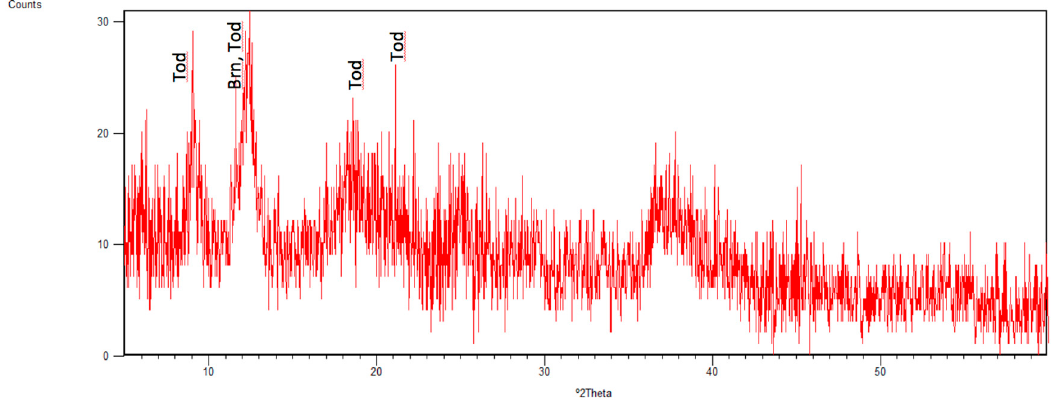
Figure 10. XRD pattern of sample GC-626 / A-75. (For mineral name abbreviations and d-spacing labeled as a plane direction of h k l , see Table 2).